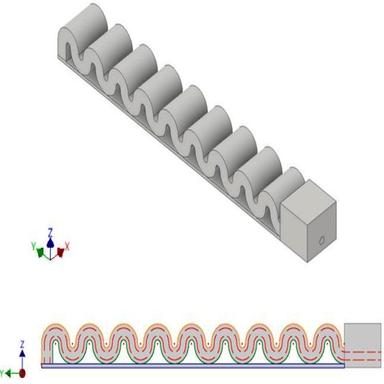
Bellow pneumatic actuator CAD model. (Orange line represents the top part of the bellow actuator; Red lines represent the internal channel; Green lines represent the bottom part of the bellow actuator; Blue lines represent the wall in the bottom part of the actuator). (For interpretation of the references to colour in this figure, the reader is referred to the web version of this article)